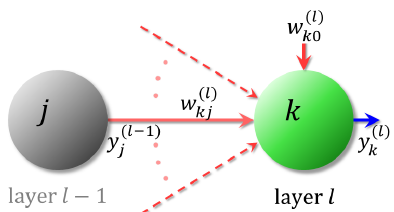
Figure 5. Neuron. Quantities associated with a neuron (green circle). Also shown is a neuron in the preceding layer (grey